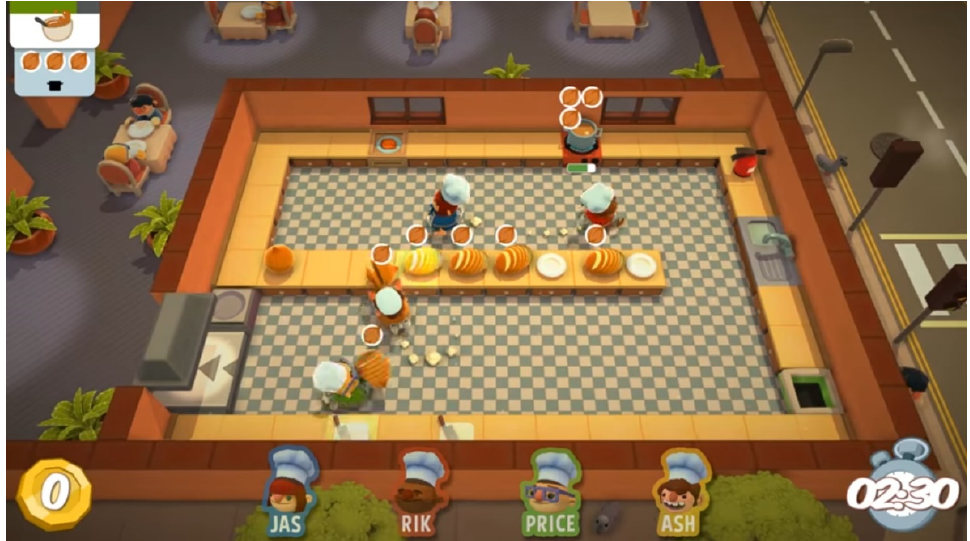
Figure 2. Screenshot of chaotic simulation game Overcooked (2016) developed by Ghost Town Games [46].